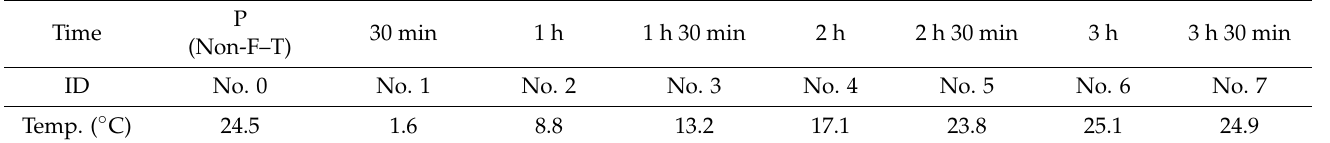
Table 3. Direct tensile test execution time and sensor surface temperature for different test subjects